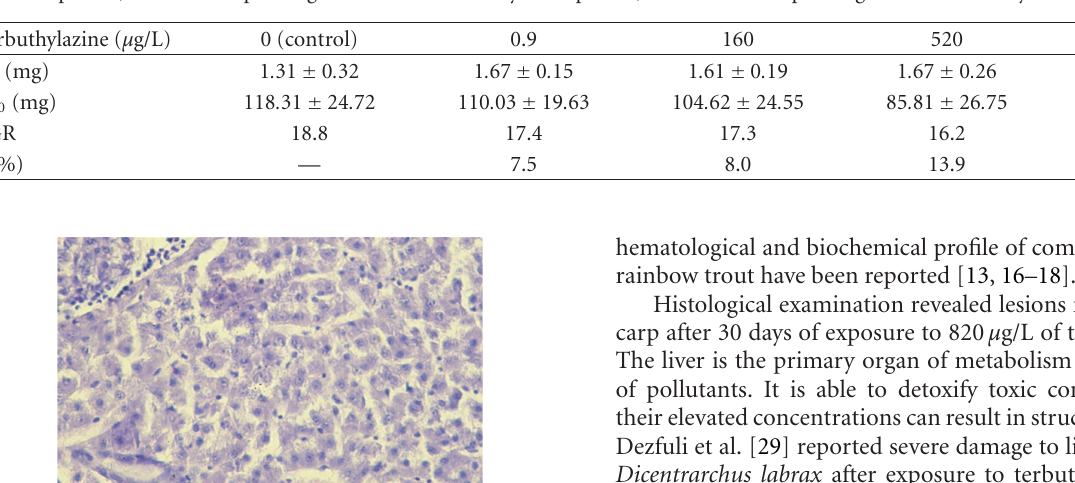
Table 1: Growth rate results of the 30-day embryolarval test on common carp. w 6 , w 30 = mean fish weight in selected group after 6 and 30 days of exposure, SGR: mean specific growth rate after 24 days of exposure, I: inhibition of specific growth after 24 days of exposure.